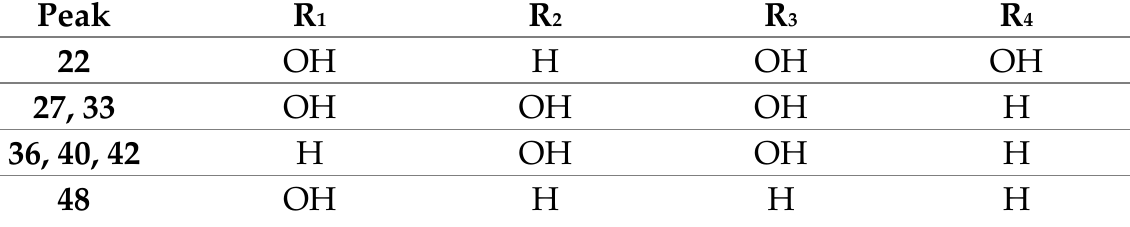
Figure 4. Structure and fragmentation of withanolide D derivatives 22 and 48. Peaks 37 (Rt = 25.93 min), 43 (Rt = 28.94 min) and 45 (Rt = 30.18 min), with [M-H] − at m / z 487.2701 (C 28 H 39 O 7 ), which were tentatively identified as previously described 24,25- dihydro-24-hydroxylated withanolide D derivatives [26], and peaks 29 (Rt = 23.64 min) and